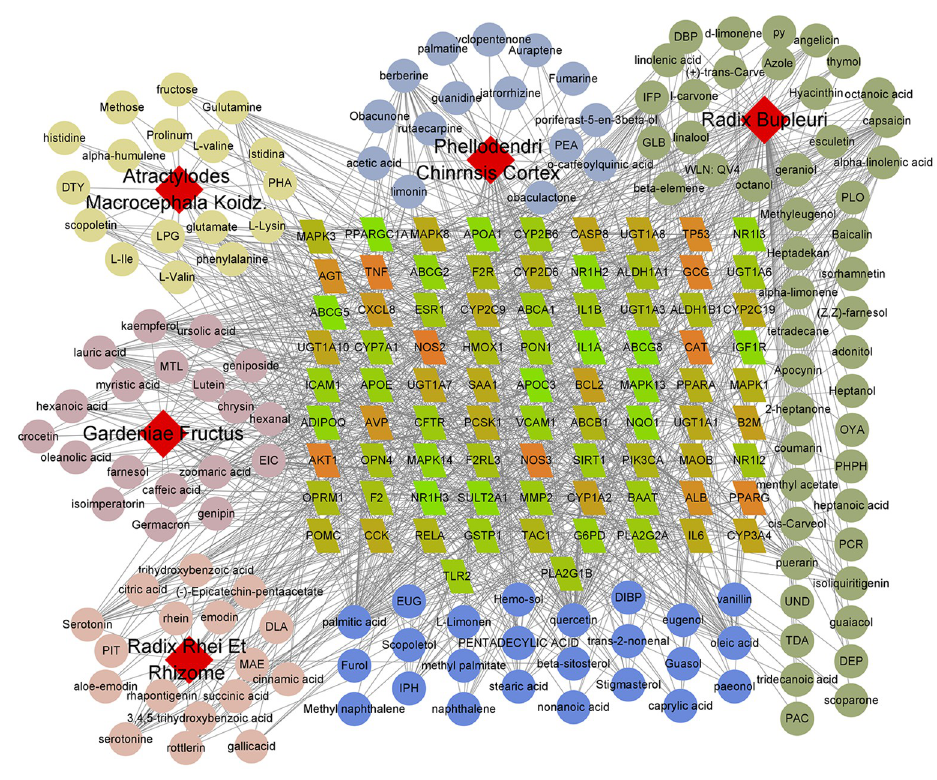
Fig 2. Compound-target (C-T) network of 141 bioactive compounds and 83 potential targets for SHCZF against cholestasis. There were 229 nodes in the C-T network, including 5 red diamonds for herbs from SHCZF, 83 orange (higher degree) and green (lower degree) parallelograms for potential targets, and 141 circles for bioactive compounds.